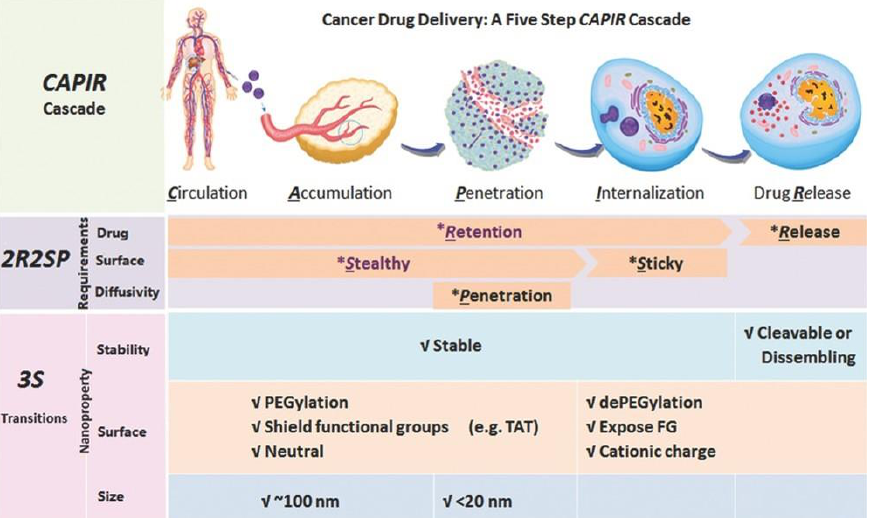
Figure 8. Summary of the 2R2SP requirements and the 3S transitions in the CAPIR cascade for a nanocarrier to have high overall drug-delivery efficiency. Reprinted with permission from Ref.